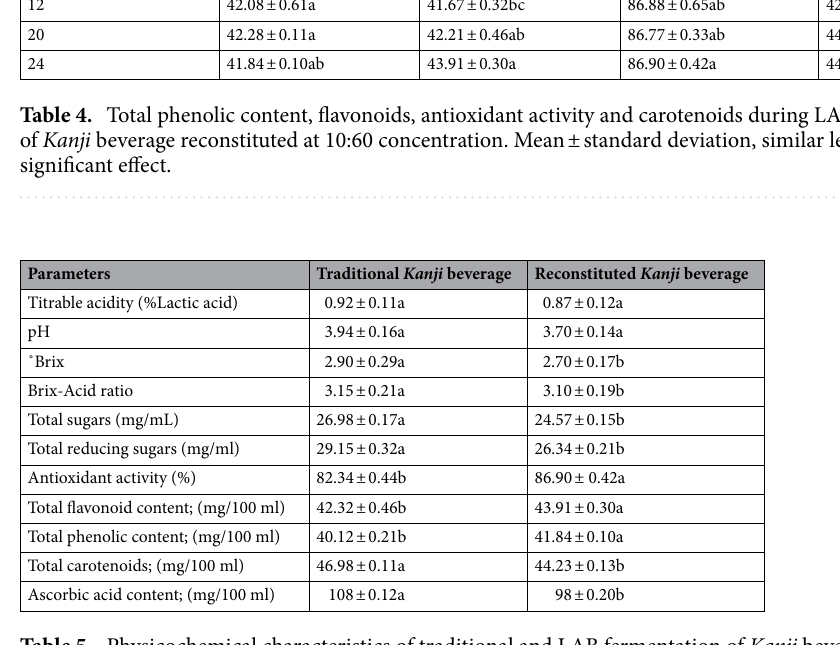
Table 5. Physicochemical characteristics of traditional and LAB fermentation of Kanji beverage reconstituted at 10:60 concentration. Mean ± standard deviation, similar letters have no significant effect.